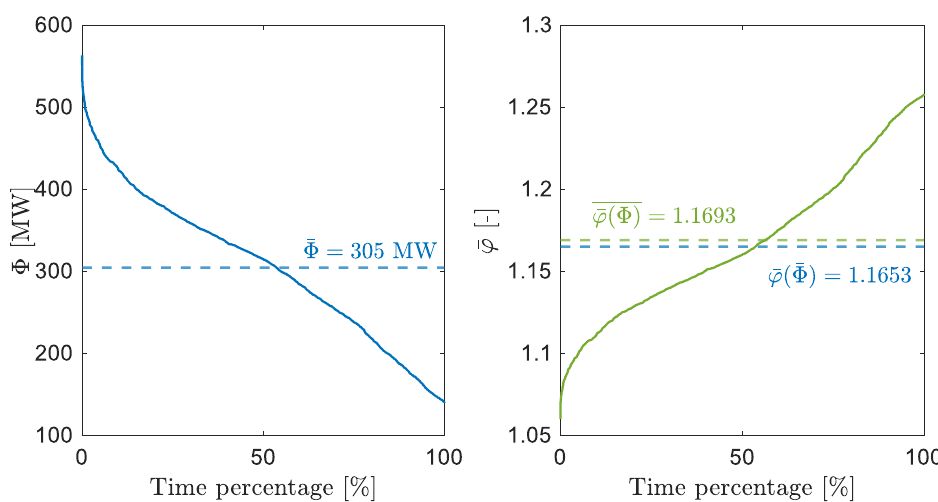
Figure 14. Steady-state load duration curve of the large-scale DH network analyzed ( left ) and values of 𝜑̅ corresponding to each steady load ( right ).